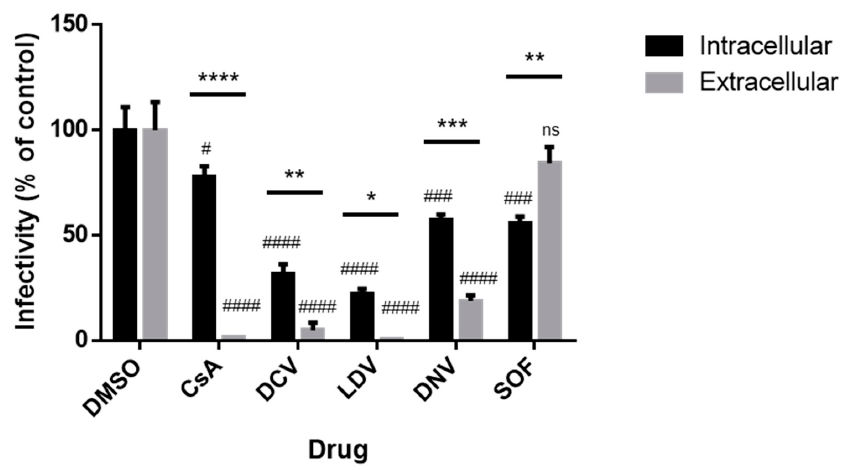
Figure 7. Impact of antivirals on intracellular and extracellular virus production. Jc1/Gluc2A-virus-infected Huh-7.5.1 cells were treated with DMSO or 100 × EC 50 of antiviral inhibitors for 8 h. Intracellular virus was obtained from four cycles of freeze–thaw cell lysate, whereas extracellular virus was precipitated by PEG from culture supernatant. Viral RNA was extracted and the viral copy number was determined by RT-qPCR. Huh-7.5.1 cells were infected with a normalized amount of the virus and analyzed for viral titers by the limited dilution (TCID 50 ) assay. Data were normalized to DMSO controls. Each data point represents the average value of 2 individual experiments. The error bars represent the SEMs. Statistical analysis was performed using 2-way ANOVA with Šid á k’s multiple comparisons test to compare the effects on intra- vs. extracellular infectivity, p -values shown over bars: * p < 0.05; ** p < 0.01; *** p < 0.001; **** p < 0.0001. Analysis was also performed to compare compound treatments to corresponding DMSO controls. p -values indicate the columns above.